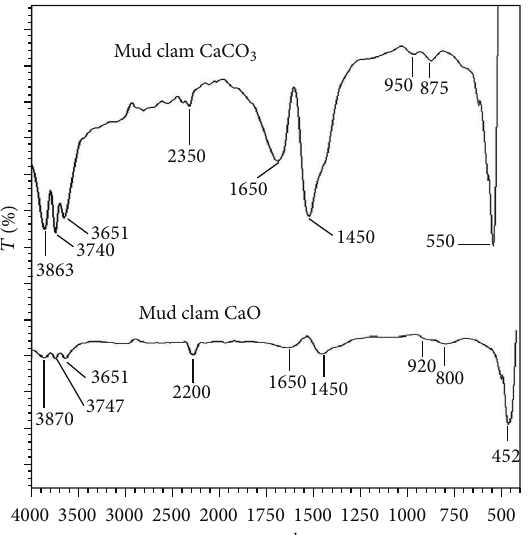
Figure 1: IR spectrum of mud clam calcium carbonate (CaCO 3 ) and calcium oxide